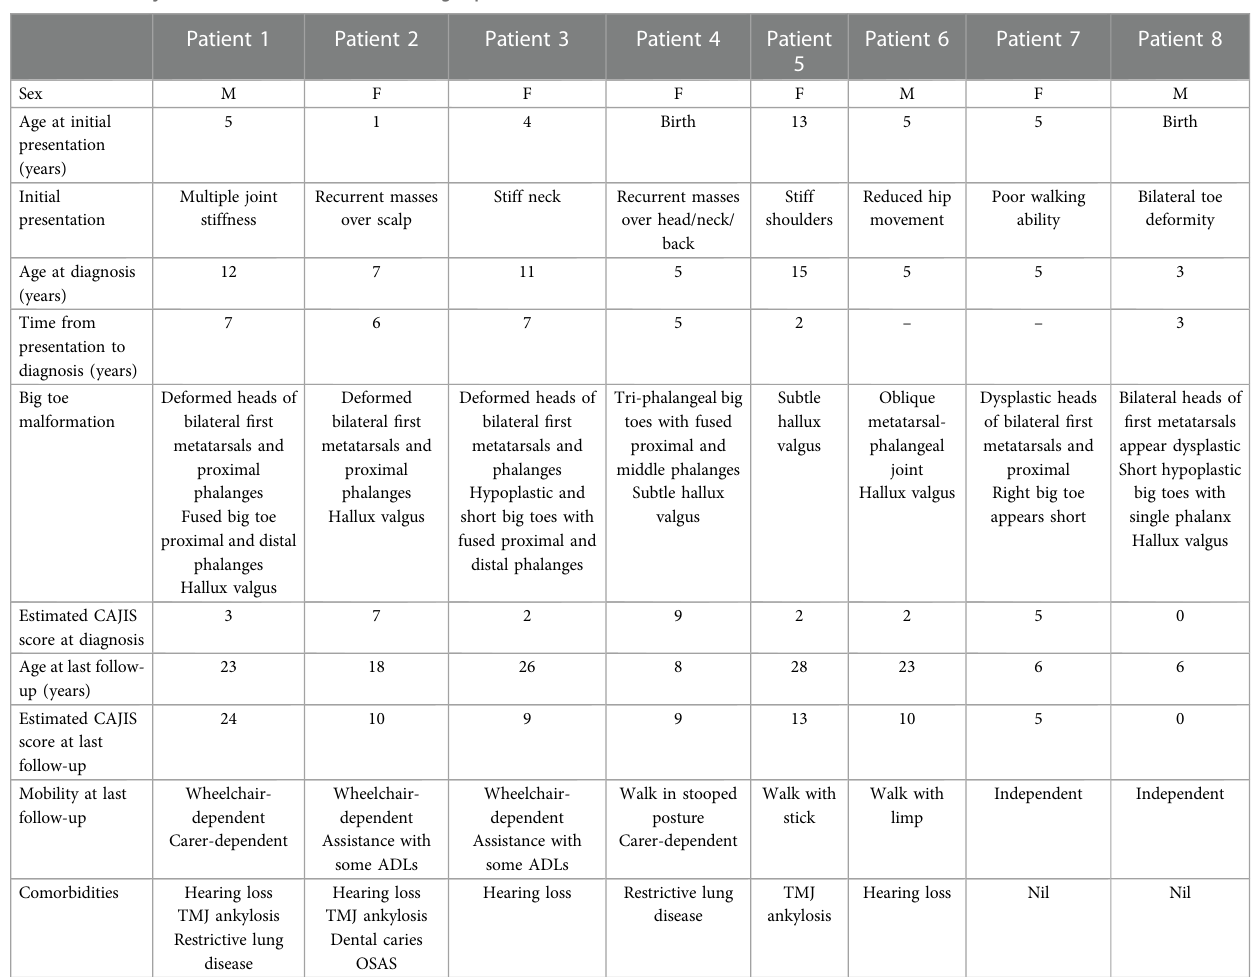
TABLE 1 Summary of clinical characteristics of all eight patients. The CAJIS scores are estimated from the latest clinical notes.